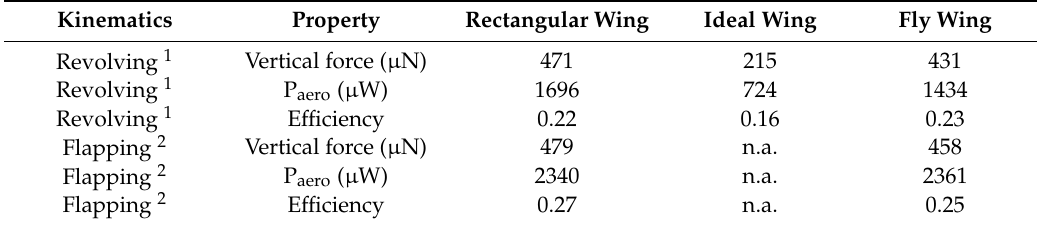
Table 1. Aerodynamic characteristics of single wings with various shape during revolving and flapping motion. Wing shapes are shown in Figures